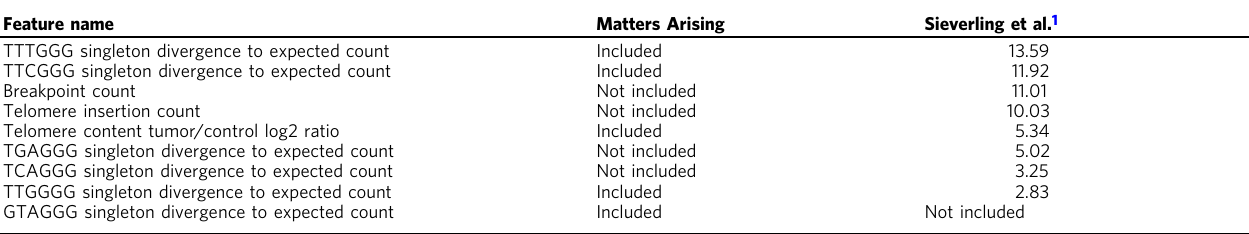
Table 1 Comparison of features for ALT, respectively, ATRX/DAXX trunc prediction. Feature name